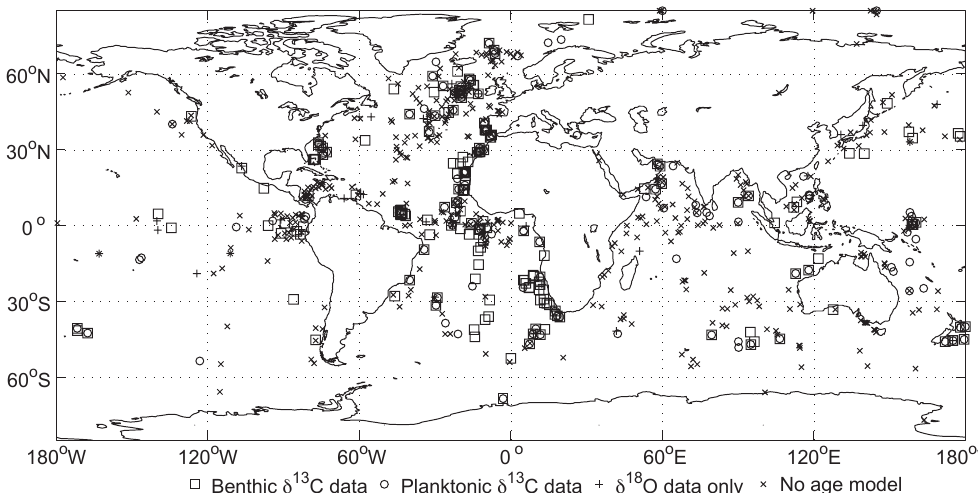
Fig. 2. Core locations of records included in the pre-processed data synthesis, or excluded because no δ 18 O-derived age model could be constructed. For most excluded records, there were too few data (often true of cores sampled only at the LGM and/or Holocene), or the sampling resolution was targeted at longer timescales than a glacial cycle. The inclusion of records in the pre-processed synthesis was not explicitly constrained by data